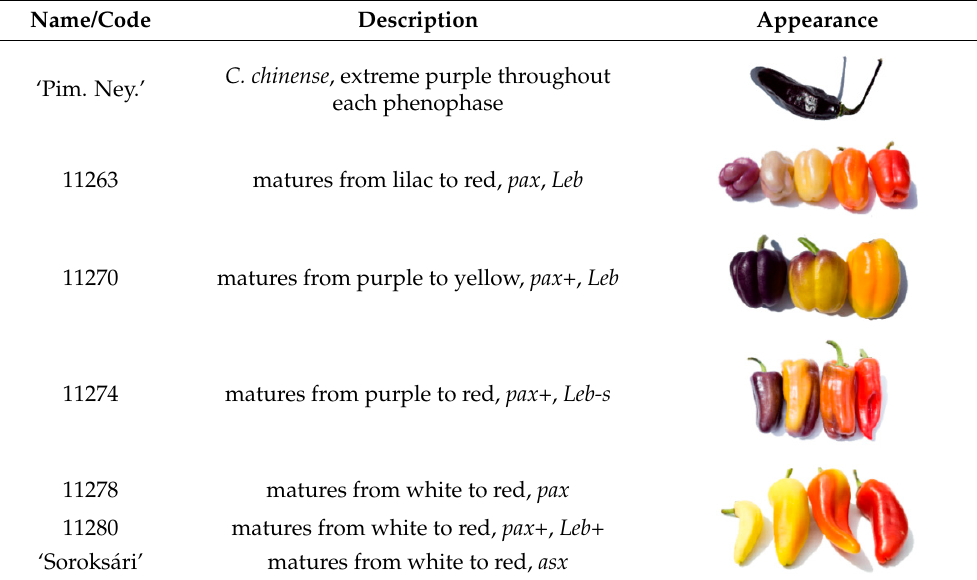
Table 1. Codes, attributes and appearance of the breeding lines. Name/Code